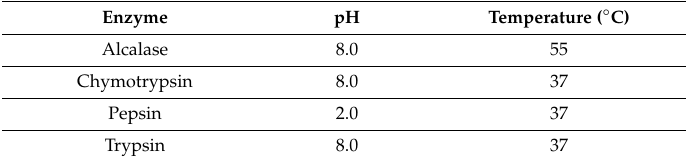
Table 1. Enzyme hydrolysis